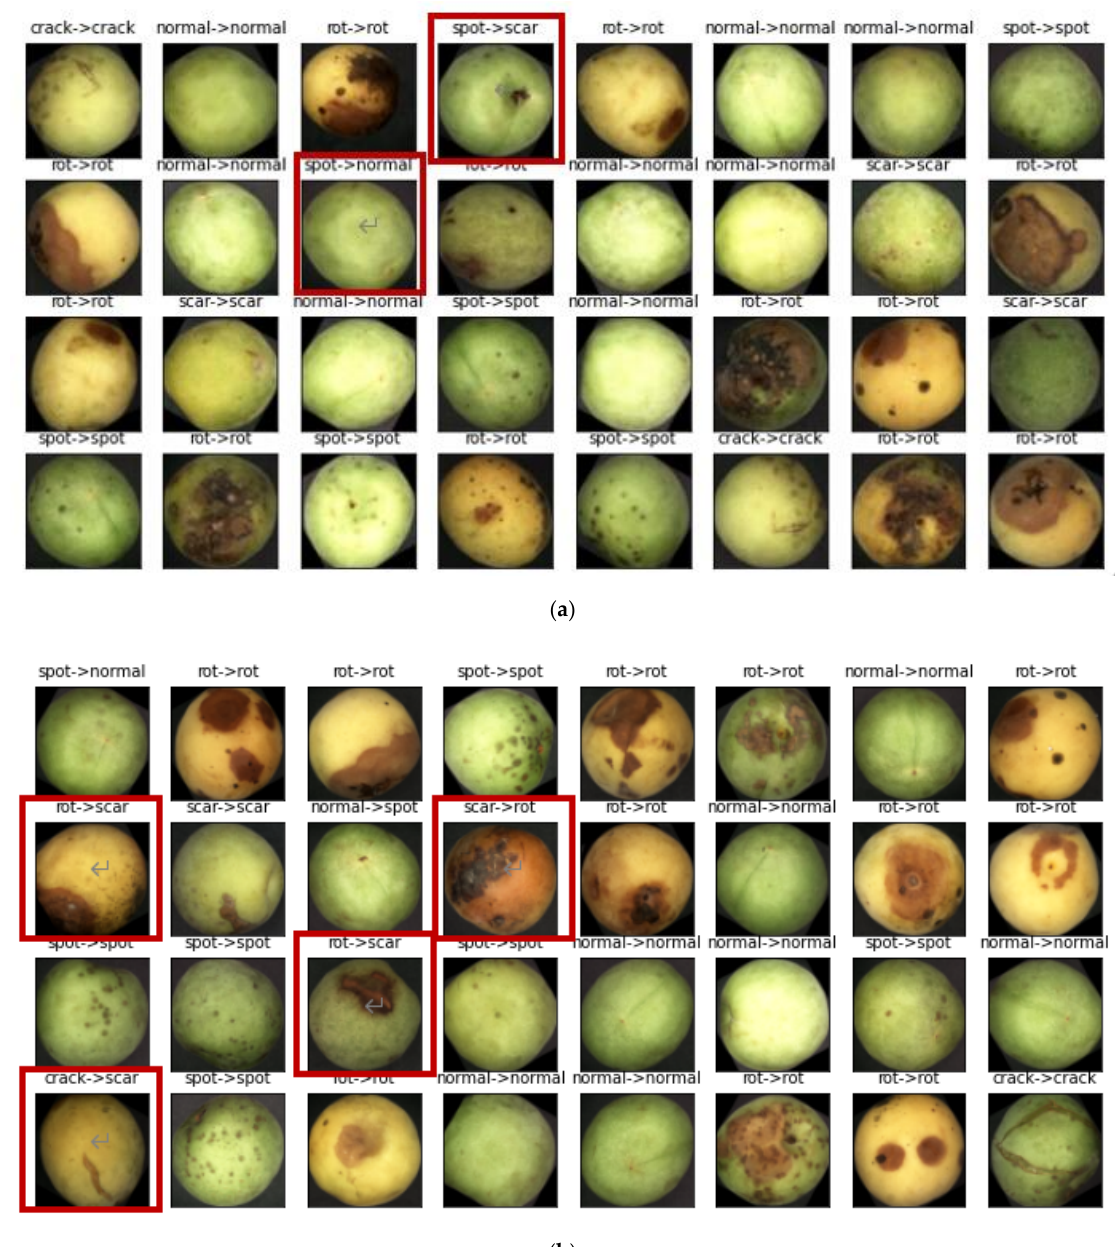
Figure 6. Results of the test ( a ) test 1 (the red box is the confusion of spot); ( b ) test 2 (the red box is the confusion of scars, crack and rot).